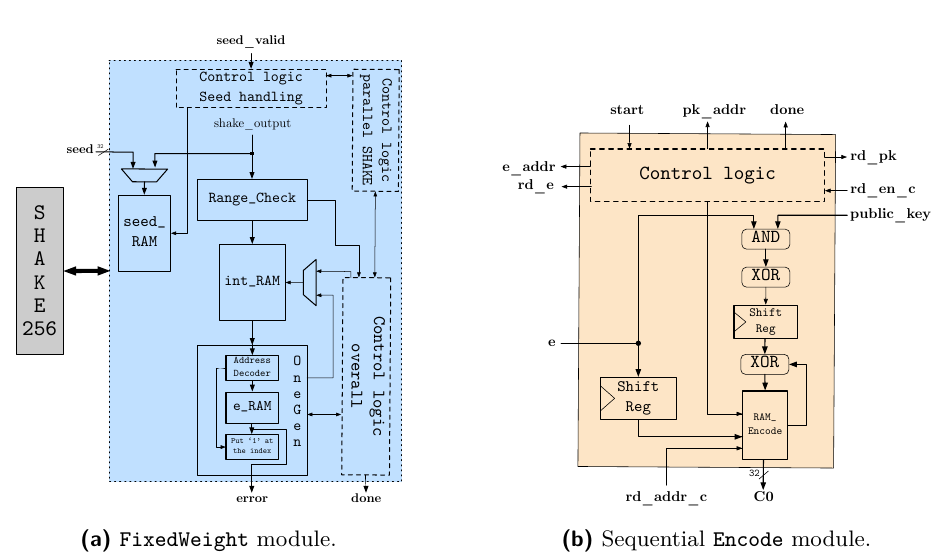
Figure 18: Hardware designs of the FixedWeight error-vector generation module and the sequential Encode